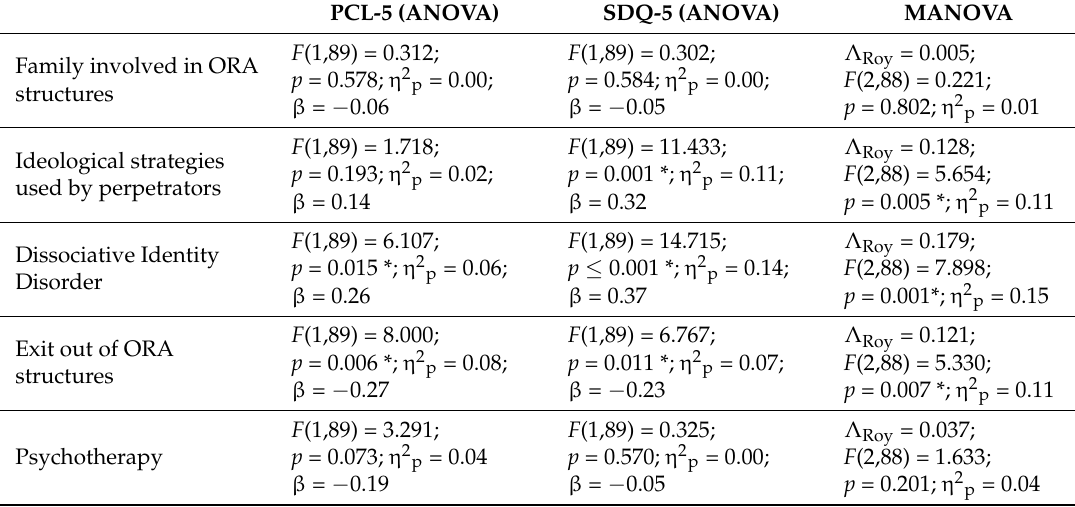
Table 6. Univariate and multivariate analyses of variance, exploring the association between ORA-related and clinical variables with trauma-related symptoms in 165 self-identified victims. PCL-5 (ANOVA) SDQ-5 (ANOVA)